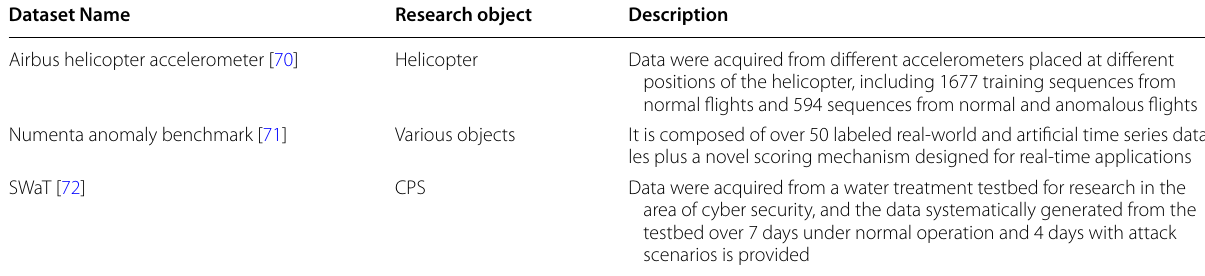
Table 1 Open source datasets for condition monitoring Dataset